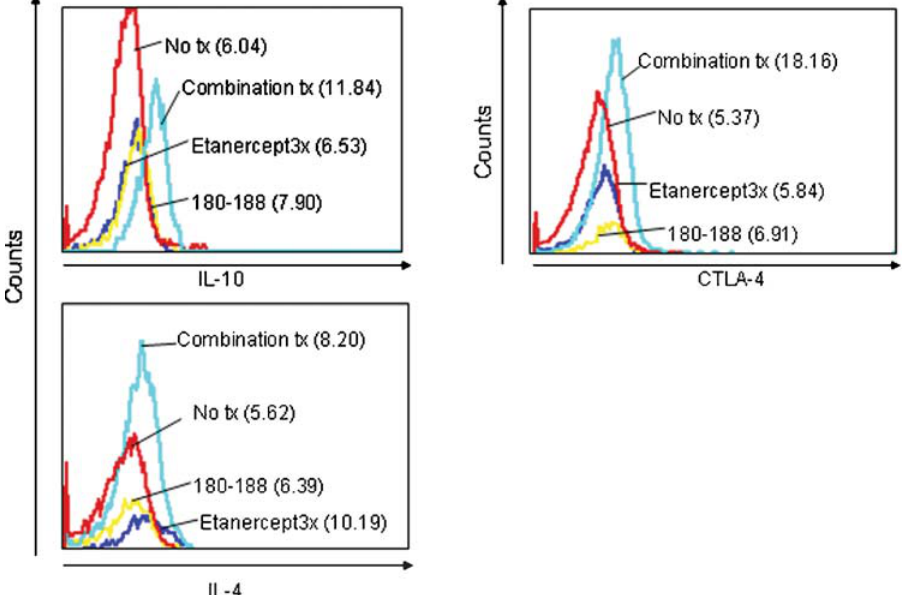
Figure 3. The combination therapy of Etanercept and HSP60 180-188 led to an antigen specific increase of IL-10 and IL-4 production and up regulation of CTLA-4 expression in CD4 + T cells in draining Mandibular Lymphnodes (MLN). MLN were harvested on day 23 after the induction of arthritis. Cells were cultured for 72 hours with medium or antigen. Intracellular production of IL-4, IL-10, and expression of CTLA-4 were measured by FACS. Depicted are Mean Fluorescence Indexes (MFI) of MLN cells cultured with mycobacterial HSP60 peptide 180-188, of cells gated on CD4. Results are representative of one experiment.